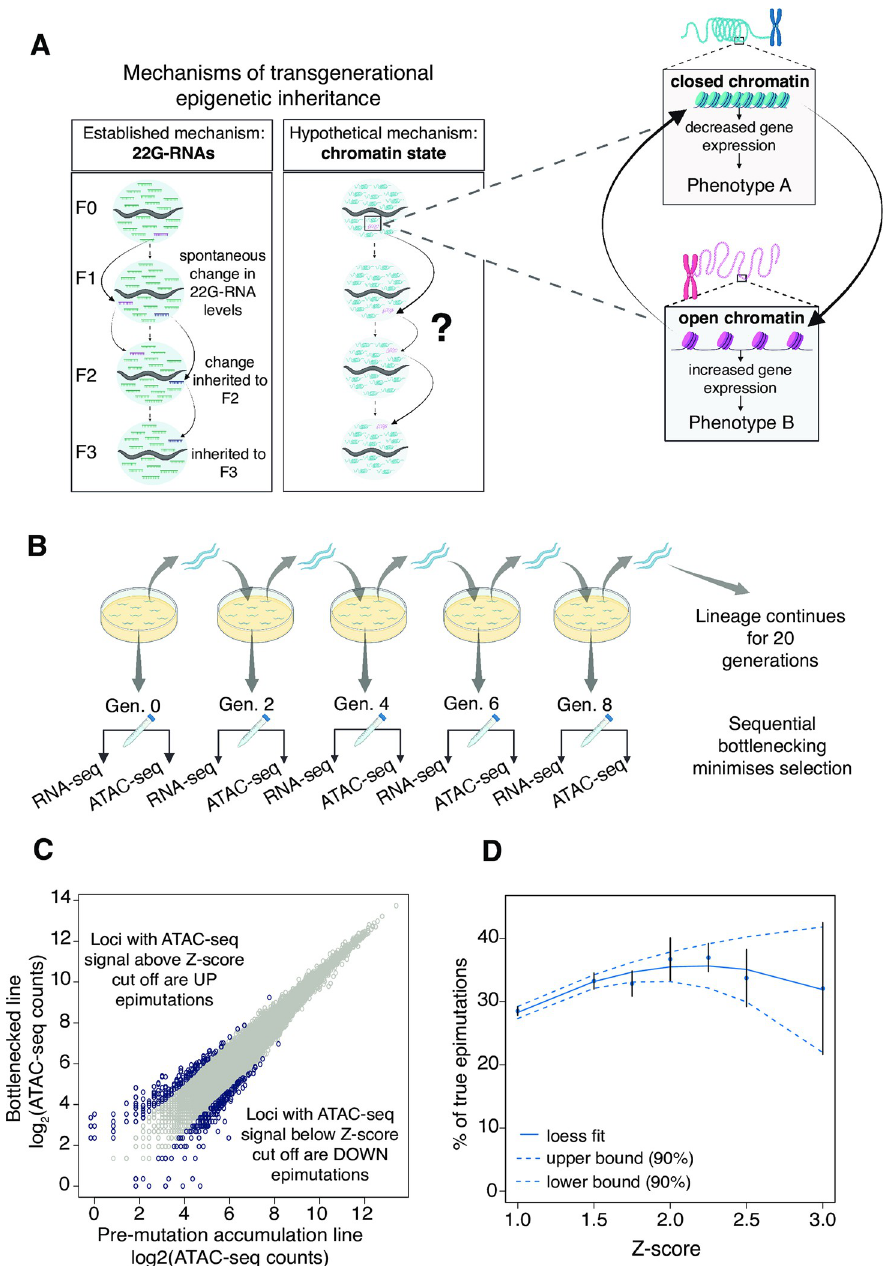
Fig 1. Identification of spontaneous chromatin-based epimutations under relaxed selection. A. Mechanisms of transgenerational epigenetic inheritance. 22G-RNAs have been established in previous work as drivers of epigenetic inheritance through the germ line. Spontaneous changes in chromatin state (epimutations) are an alternate mechanism. B. Experimental design. Three independent lineages of C . elegans nematodes were grown with bottlenecking for a total of 20 generations including a non-restricted pre-mutation-accumulation (PMA) generation (Gen. 0). Paired RNA-seq and ATAC-seq libraries were produced from the PMA generation and at alternate generations from generations 2–20. RNA was further processed to produce small RNA libraries. C. Identification of chromatin-based epimutations. Epimutated loci were defined as regulatory element loci with ATAC-seq counts (rings on plot) that were significantly greater (UP) or lower (DOWN) than that of the same locus in the PMA generation according to a Z-score cut off. UP epimutations correspond to increased opening of chromatin while DOWN epimutations reflect chromatin closing. D. Simulation to identify optimal Z-score cut-off. X-axis shows range of Z- score cut-offs tested. Y-axis shows difference between the percentage of epimutations inherited for two or more generations compared to the predicted percentage if epimutations occurred randomly but were never